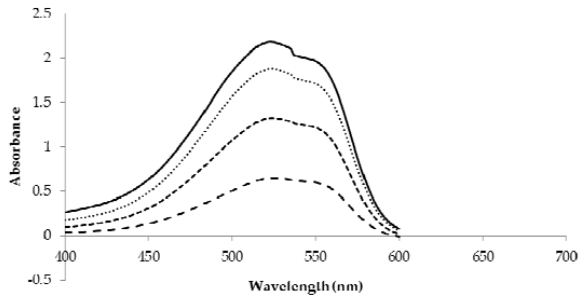
Figure 2. Measured absorption spectra of the TTI solution at different concentrations. “—”: measured by 40 mM glucose and GOx, ⋅ ⋅ ⋅ ⋅ ⋅ : 30 mM glucose and GOx , - - - - - : 20 mM glucose and GOx , – – – – : 10 mM glucose and